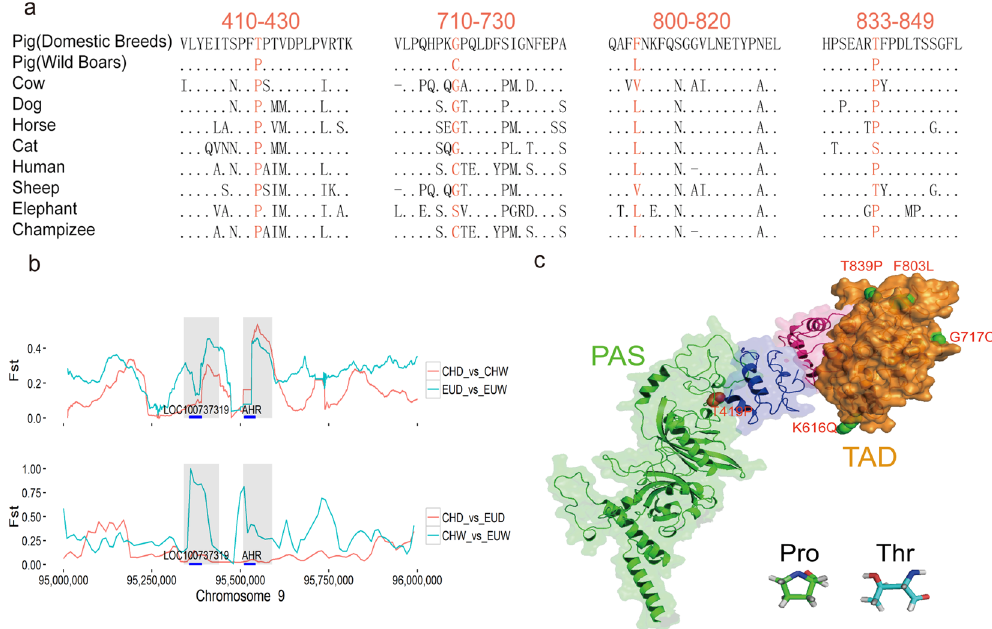
Figure 5. The variants in AHR gene and their effects. ( a ) The multi-species alignment of 4 non-synonymous substitutions encoded in the AHR gene. Dots indicate identity with the master sequence, and dashes indicate missing data. ( b ) Example of a gene under unidirectional selection pigs. FST values plotted using a 20-kb sliding window. ( c ) Predicted three-dimensional protein structure of AHR. Five non-synonymous substitutions are shown as spheres (P419T, brown; K616Q, G717C, F803L and T839P,